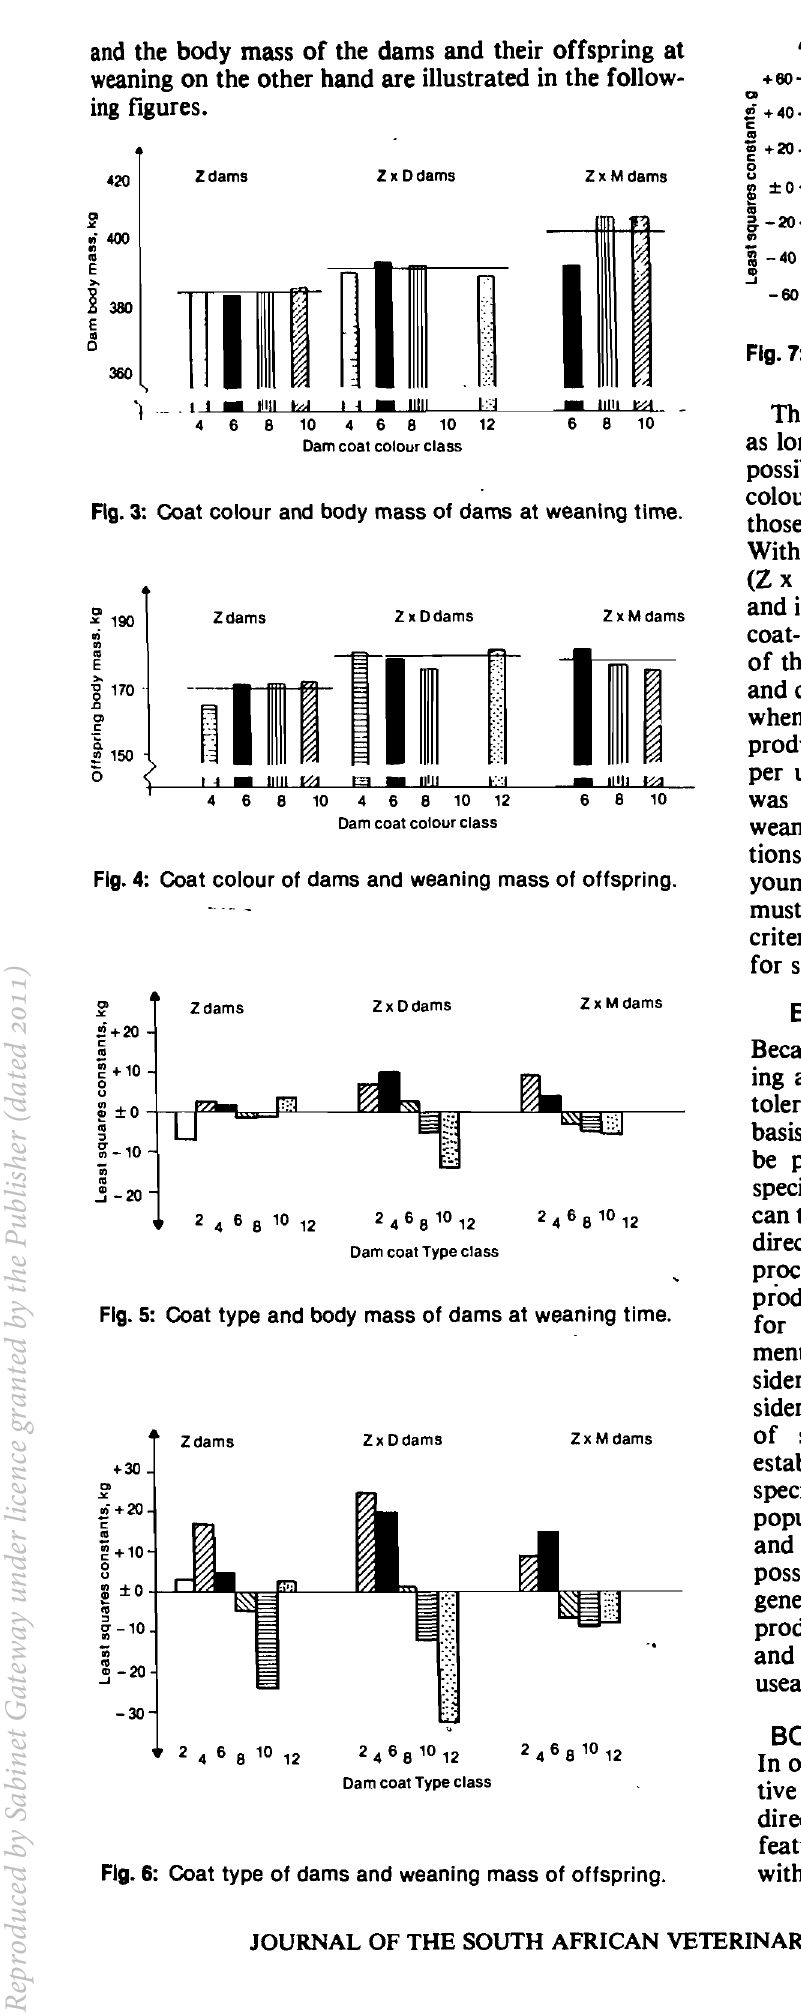
Fig. 6: Coat type of dams and weaning mass of offspring.